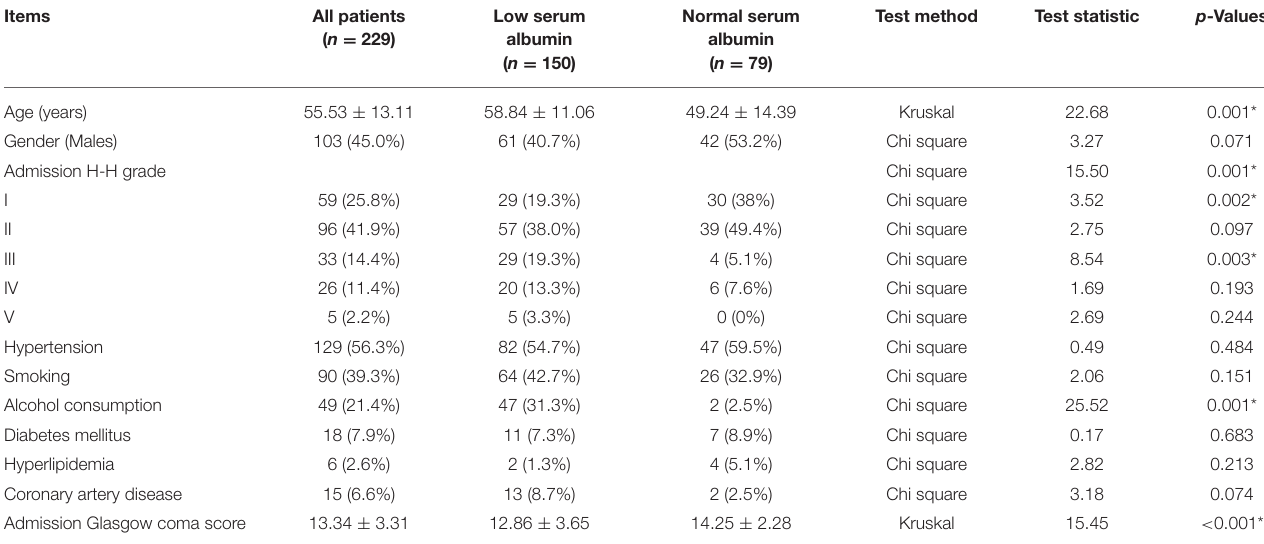
TABLE 1 | Baseline characteristics of patients with spontaneous subarachnoid hemorrhage. Items All patients ( n = 229)